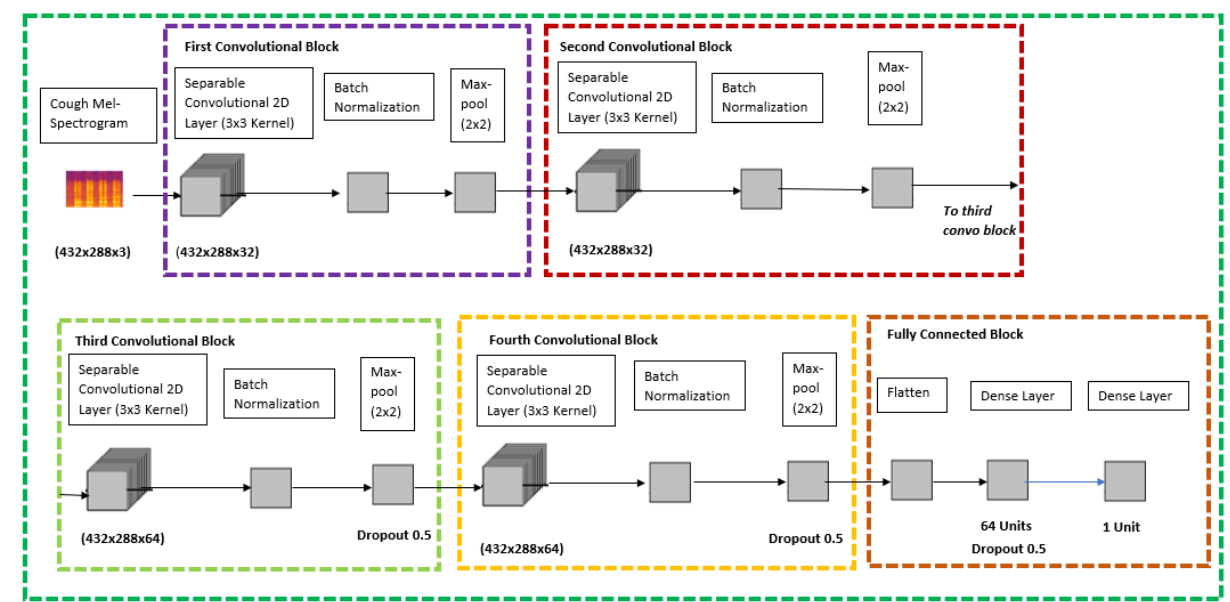
Figure 4. Architecture for Cough Model.